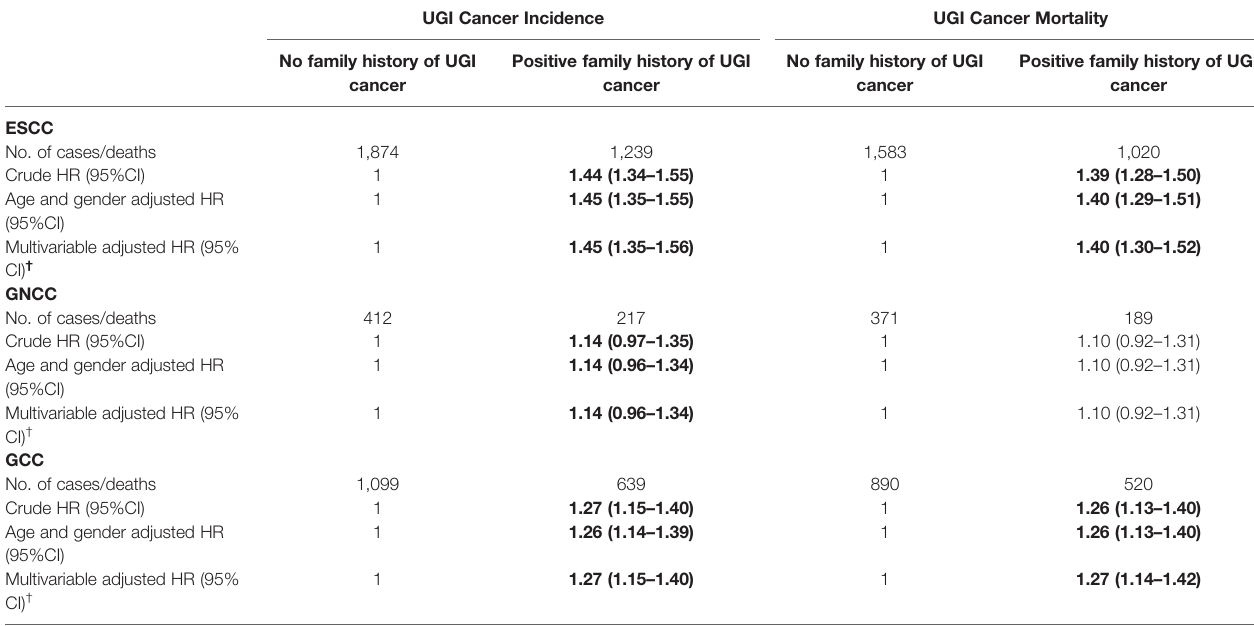
TABLE 2 | Crude and adjusted hazards ratios (HRs) and 95% con fi dence intervals (CIs) for the associations between family history of UGI cancer and risk of ESCC, GCC, and GNCC incidence, and mortality.